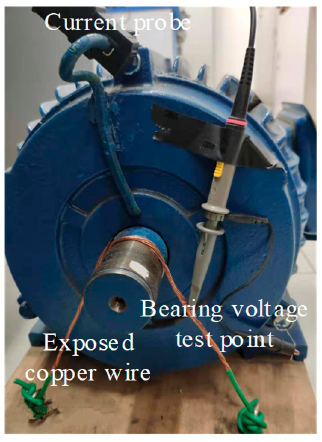
Figure 3. The test point display.